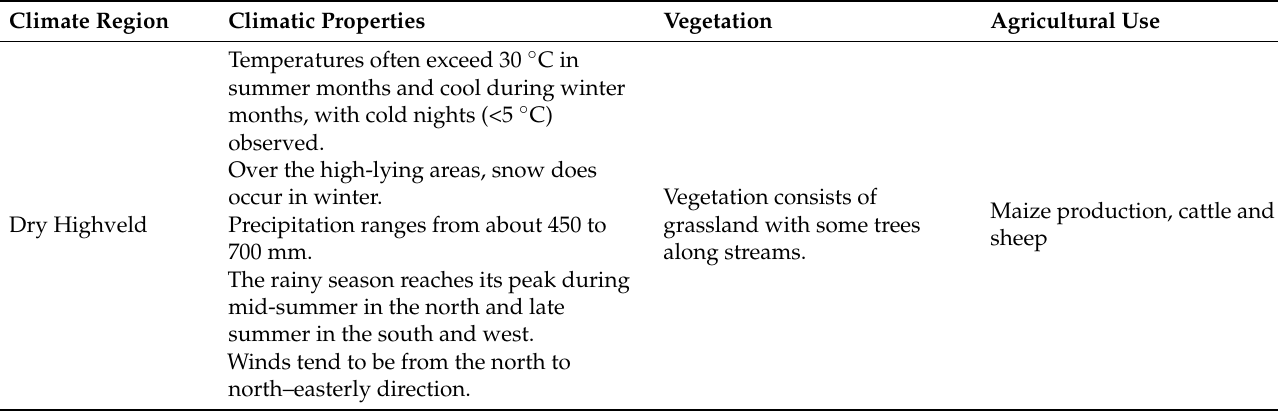
Table 1. Summary of climate properties of dry Highveld [25].